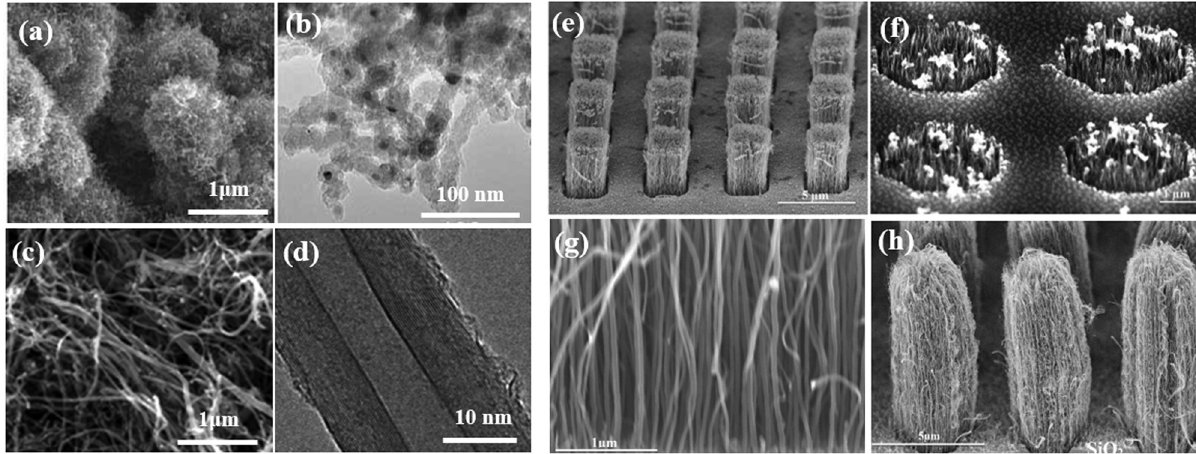
Figure 3: ( a ) Scanning electro microscopy ( SEM ) diagram of short CNTs. ( b ) Transmission electro microscopy ( TEM ) image of CNTs [ 5 ]